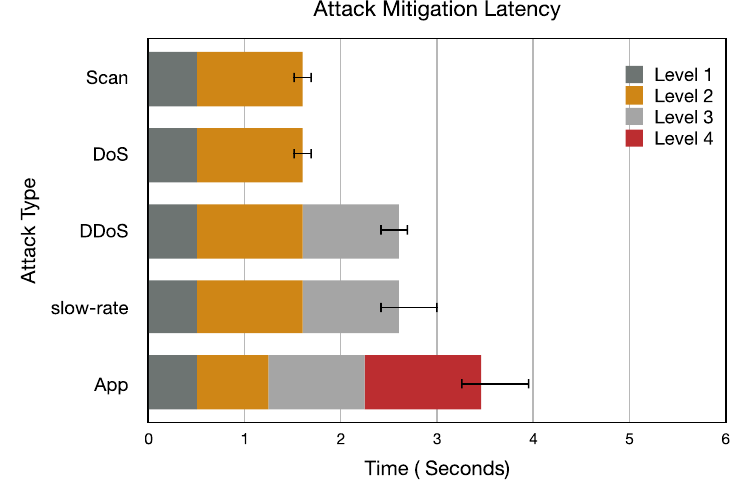
Fig. 34 Detection Times for different classes of attacks